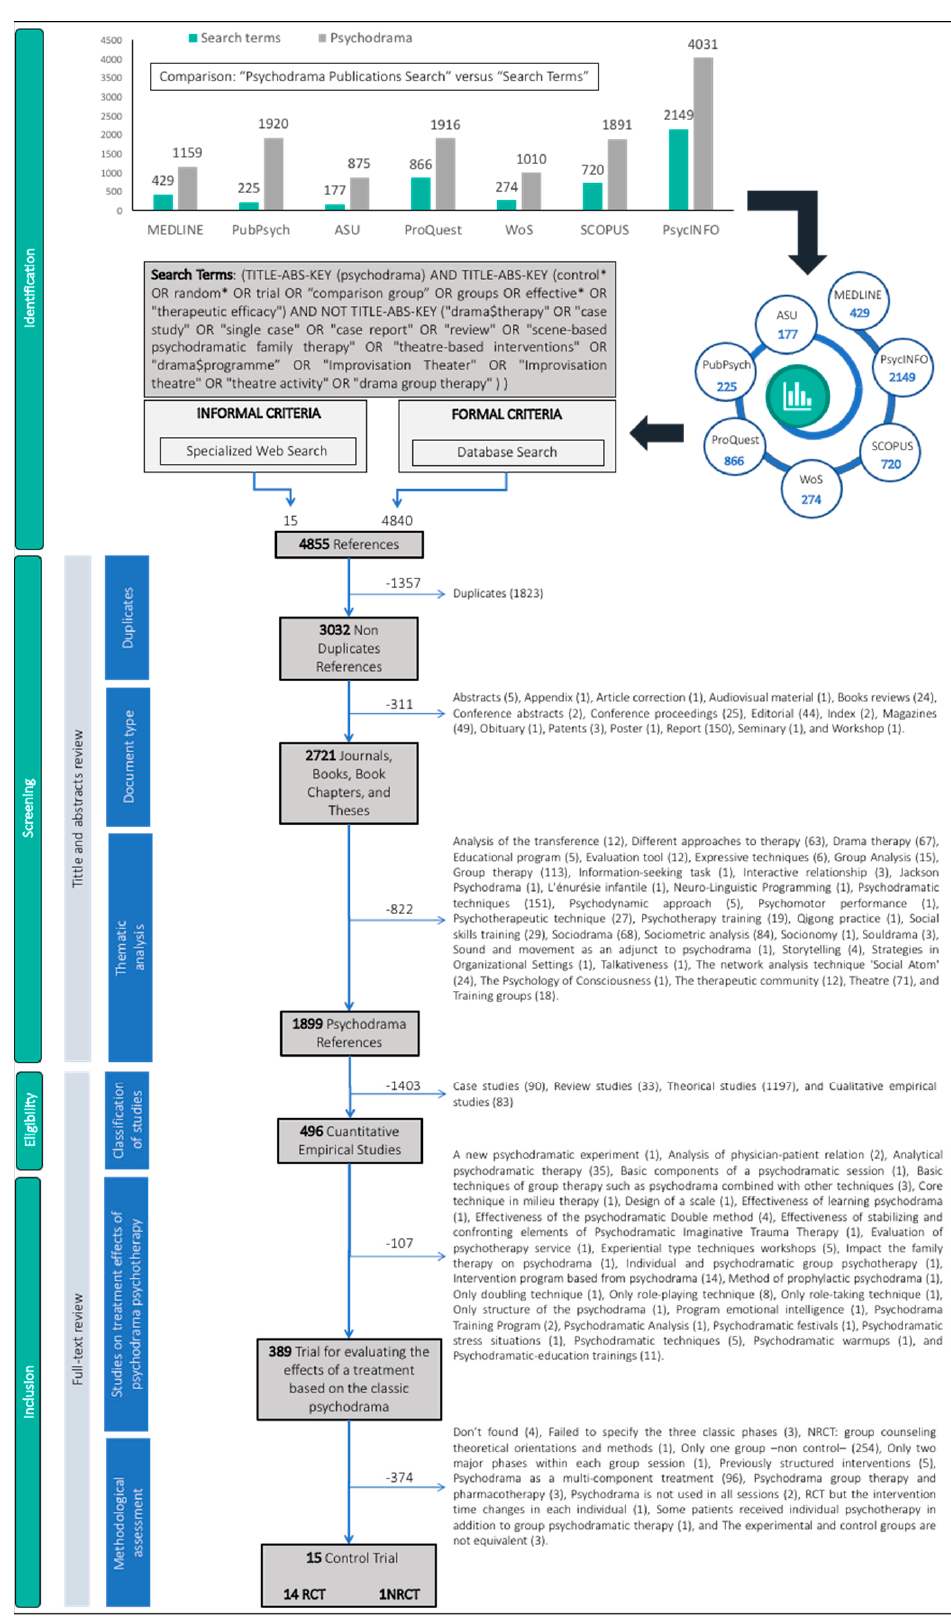
Figure 1. Flow of information through the different phases of the systematic review. Note: TI (title), AB (abstract), KW (keywords), RCT (randomized controlled trial), q-RCT (quasi-randomized controlled trial).